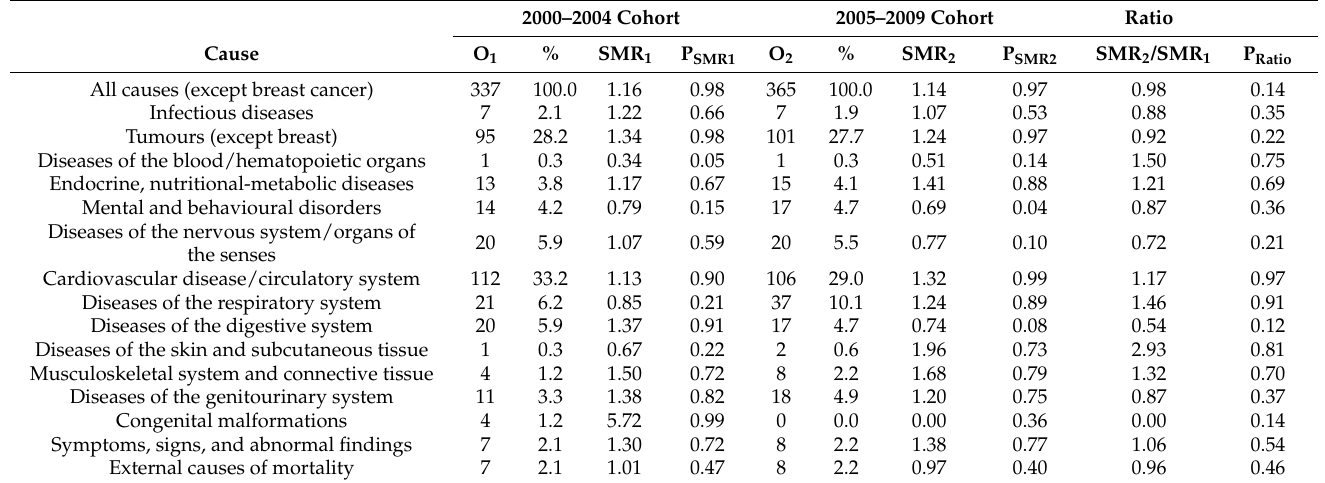
Table 2. Comparison of the SMRs between the 2000–2004 cohort and the 2005–2009 cohort according to the grouped causes of death, excluding breast cancer